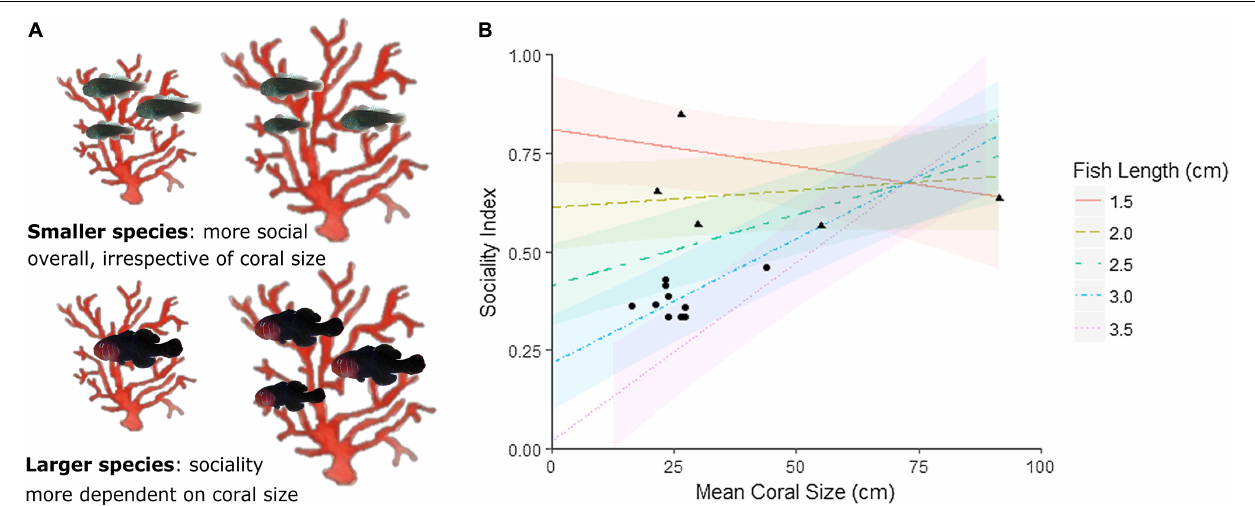
FIGURE 5 | Relationships between social group size, host Acropora coral size, and body size for species in the genus Gobiodon . (A) Schematic depicting variation in group sizes between small and large species in relation to coral size; (B) modeled predictions for interactions between coral size and body size (fish length) and their effects on the sociality index (encompassing the proportion of groups within the population, proportion of subordinates within groups, and proportion of the life cycle spent in groups; see Avilés and Harwood, 2012) for Gobiodon species. Raw data are the black symbols where pair-forming species are represented by circles and group-forming species are represented with triangles. Modeled body sizes are represented by the colored lines shown in the legend (Figure modified from Hing et al., 2019). The figure is reproduced with permission from